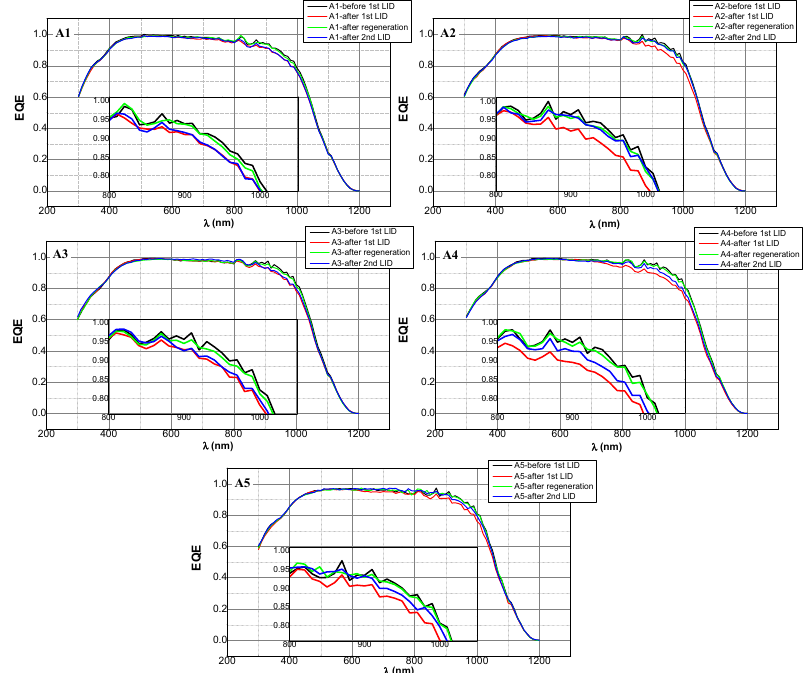
Figure 6. EQE curves of the five groups of Al-BSF solar cells at four breakpoints of treatments (before and after the 1st LID, after regeneration and the 2nd LID).